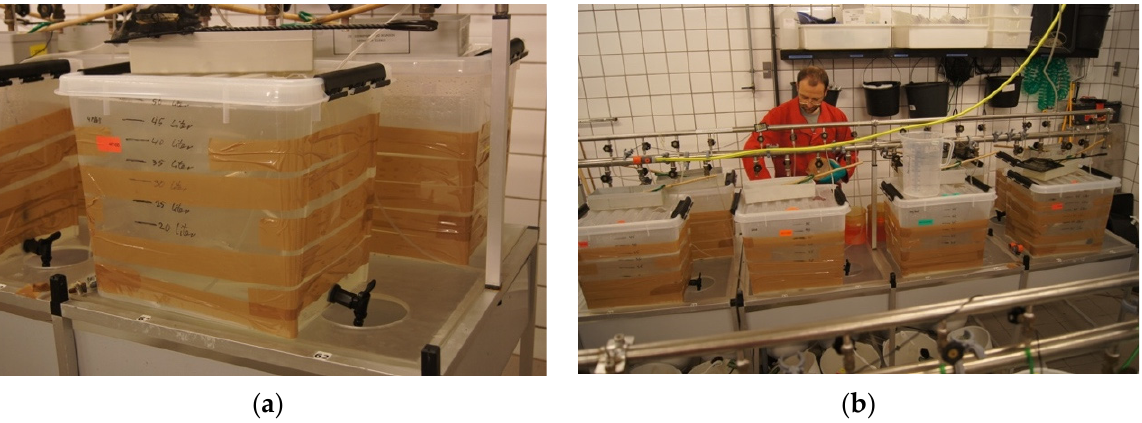
Figure 1. ( a , b ). The experimental system with fish tanks, of which 7 were used in the